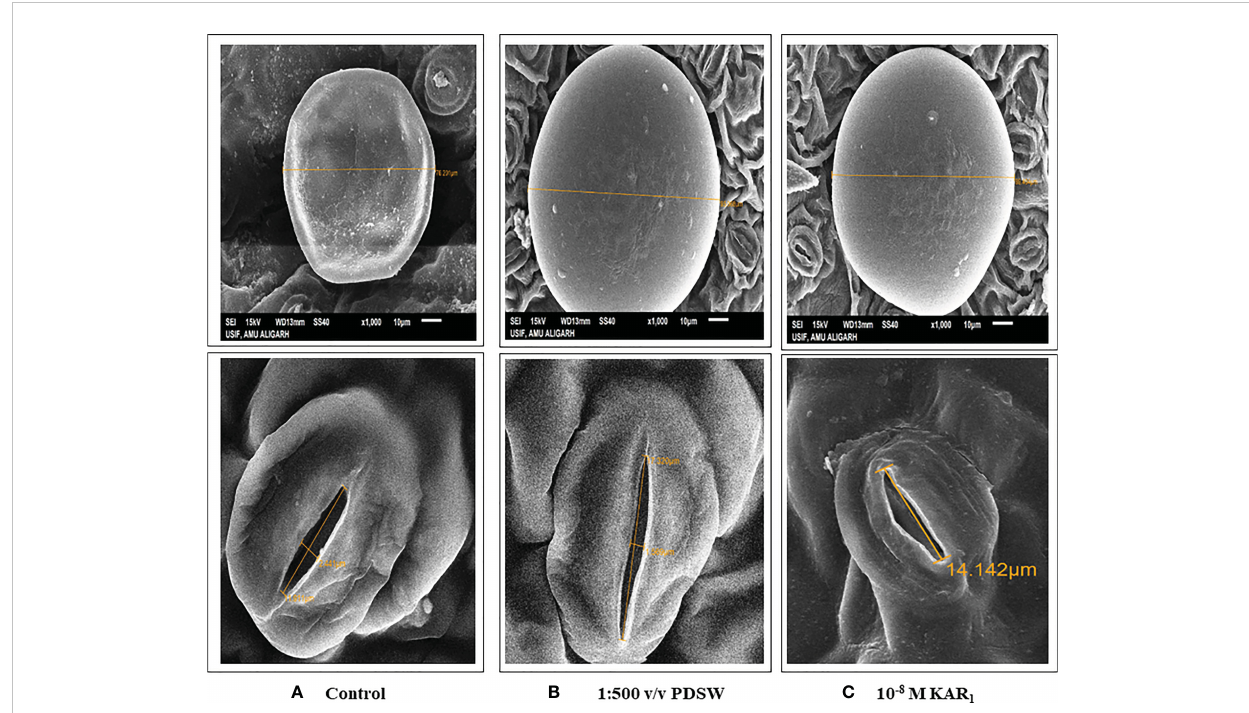
FIGURE 4 Response of Mentha arvensis L. to foliar treatment with smoke-saturated water (PDSW) and KAR 1 regarding size of leaf glandular trichomes and length of stomatal pore as observed under scanning electron microscope as affected by (A) Control (B) 1:500 v/v of PDSW and (C) 10 -8 M of KAR 1